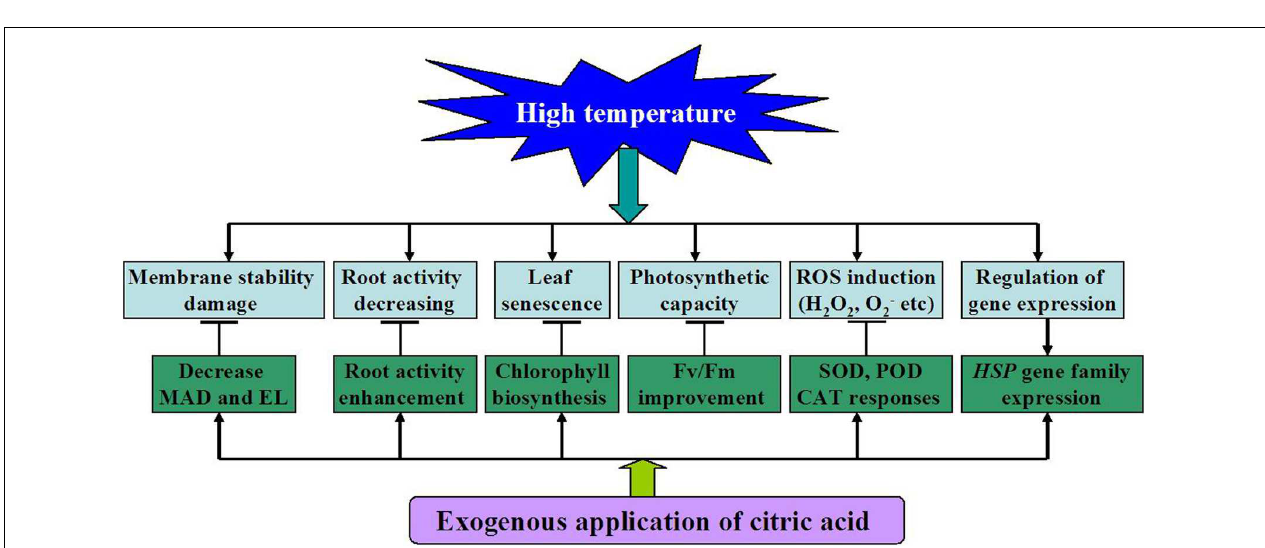
FIGURE 7 | Effect of exogenous citric acid on the expression of heat shock protein ( HSP ) gene family under control (25/20 ± 0.5 ◦ C, day/night) and heat stressed (35/30 ± 0.5 ◦ C, day/night) conditions in tall fescue. (A) HMW-HSP; (B) LMW-HSP; (C) HSP74.8; (D) HSC70 ; Vertical bars on the top provide the standard deviation ( n = 4), and bars with the same letter indicate no significant difference at P < 0.05 for the comparison of different citric acid concentrations under control or heat stress.